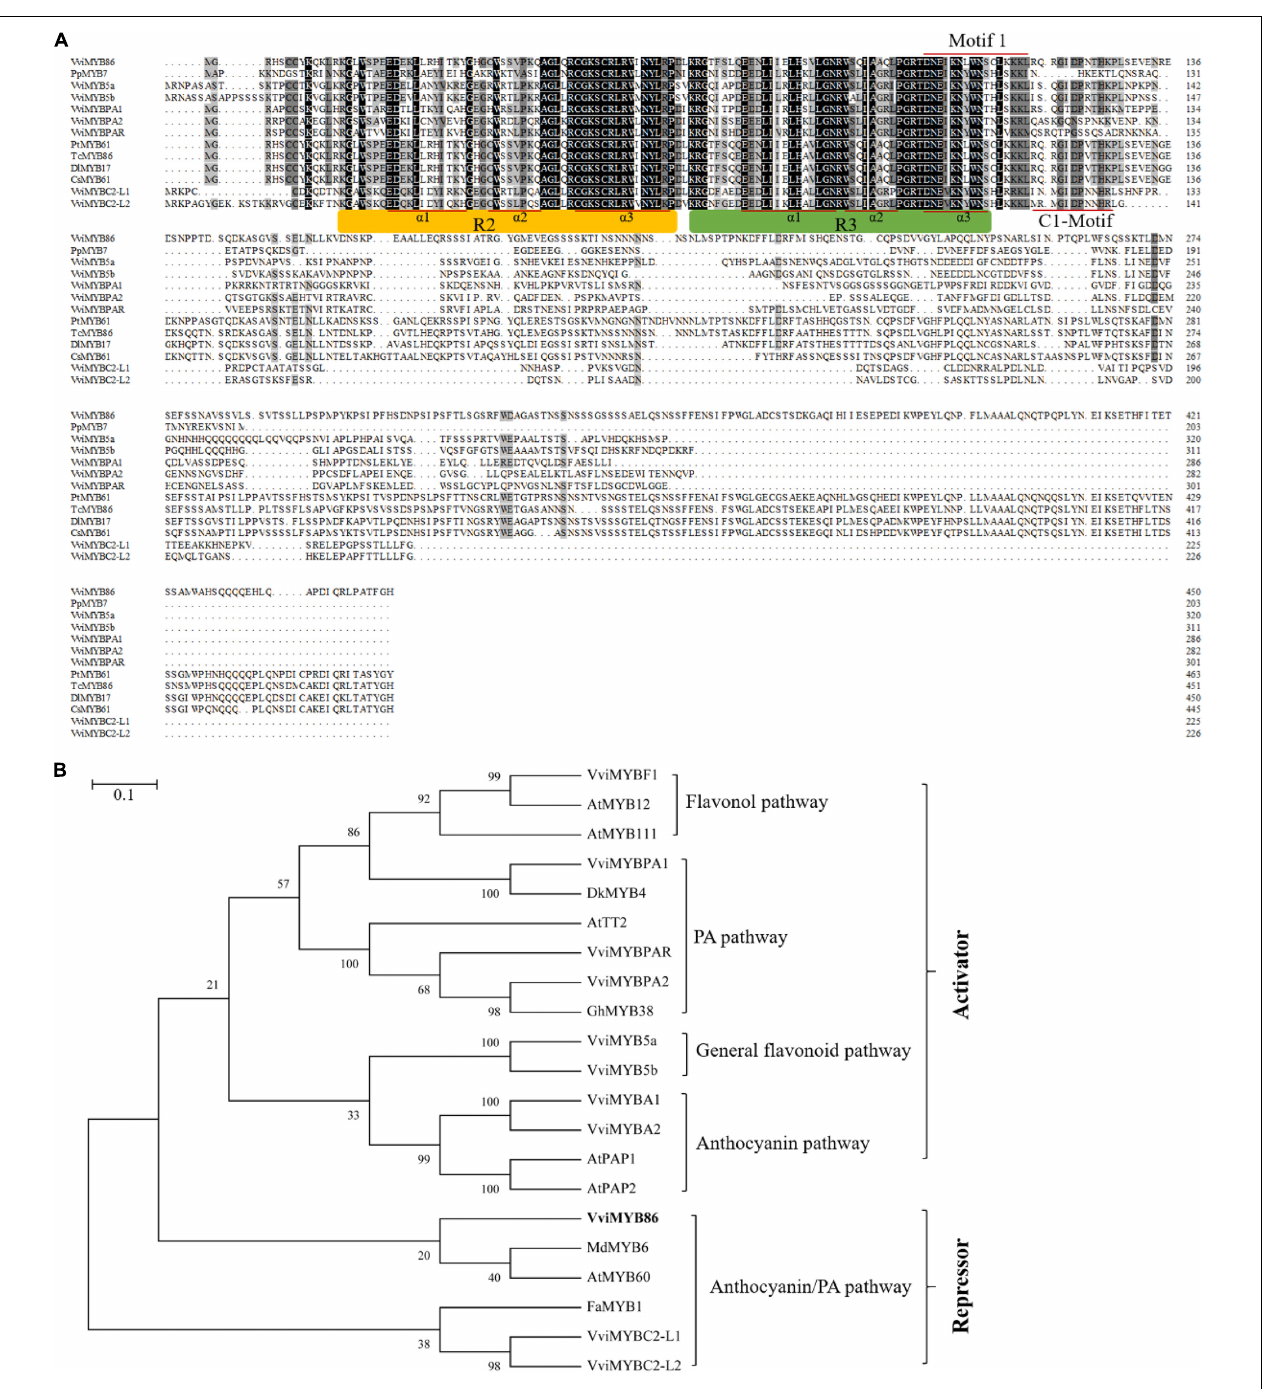
FIGURE 1 | The deduced peptide sequences of VviMYB86 and related MYB’s. (A) Polypeptide alignment analysis of the full-length amino acid sequences of VviMYB86 and other PA-related R2R3 MYB transcription factors (TFs) as well as TFs with high homology. Conserved residues were highlighted in black, and partial conservation was indicated in gray. The R2 and R3 MYB DNA binding domains were indicated above the alignment. The alpha helices of R2 and R3 repeats were indicated with red lines. Motif 1 [DNEI(A/S/G)N(D/A/N)V] and C1-Motif (lsrGIDPxT/NHR) were indicated by underlining with red line. (B) Phylogenetic tree of MYB TFs related to VviMYB86. The phylogenetic tree was constructed using Neighbor-Joining method of MEGA 7.0 software. The scale bar represents the number of substitutions per site. The putative regulatory functions of most of the proteins in the control of flavonoid biosynthesis are indicated. GenBank accession numbers are as follows (in parentheses): AtTT2 (Q9FJA2), AtMYB12 (NP_182268), AtMYB111 (NP_199744), AtMYB60 (AAC83617), AtPAP1 (AAG42001), AtPAP2 (NP_176813), VviMYB5a (AAS68190), VviMYB5b (AAX51291), VviMYBPA1 (CAJ90831), VviMYBPA2 (ACK56131), VviMYBPAR (XP_003633091), VviMYBF1 (ACT88298), VviMYBA1 (BAD18977), VviMYBA2 (BAD18978), VviMYBC2-L1 (ABW34393), VviMYBC2-L2 (ACX50288), DkMYB4 (BAI49721), FaMYB1 (AAK84064), GhMYB38 (AAK19618), GhMYB10 (ABV53918), and MdMYB6 (AAZ20429).